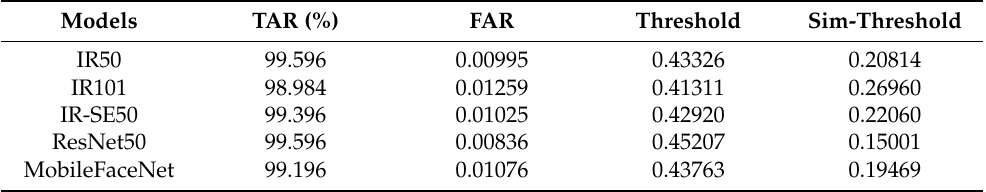
Table 1. The TAR and corresponding thresholds for different